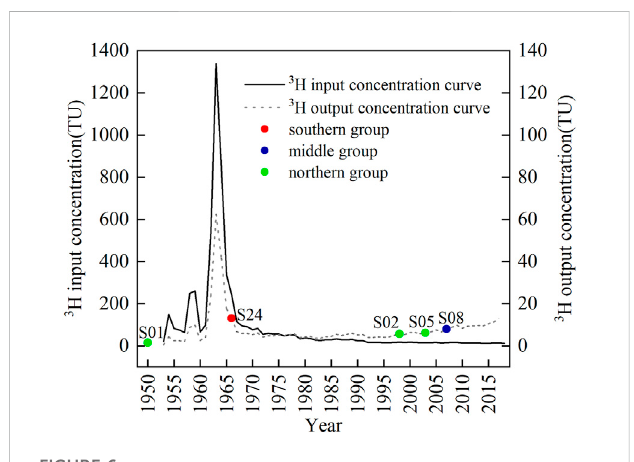
FIGURE 6 3 H input concentration in precipitation and 3 H output concentration